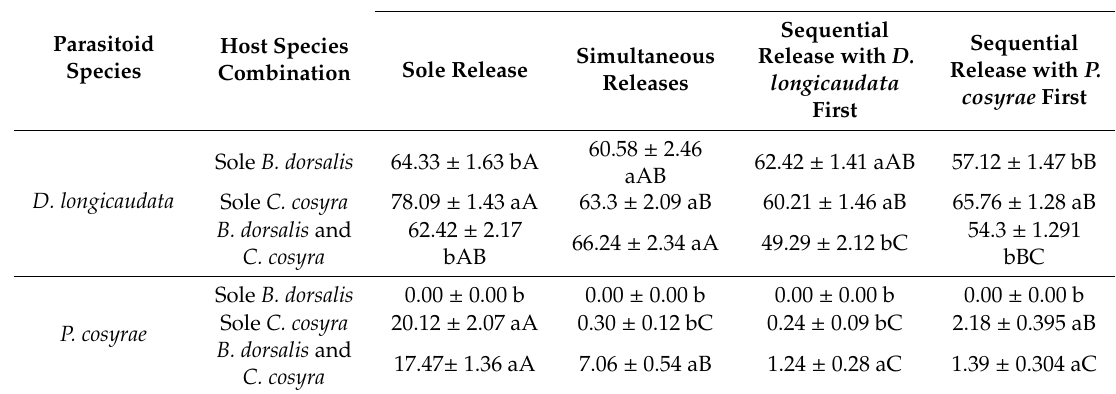
Table 2. Mean percent ( ± SE) of specific parasitism rates (%) of Diachasmimorpha longicaudata and Psyttalia cosyrae on two fruit fly species Bactrocera dorsalis and Ceratitis cosyra following various release combinations under laboratory